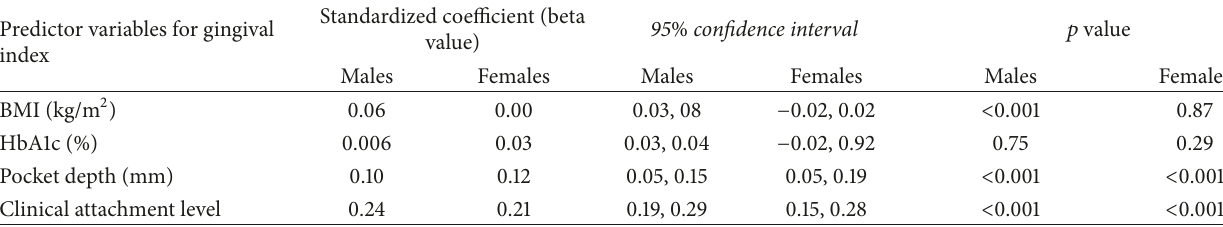
Table 6: Gender specific predictors of gingival index in patients with T2DM.